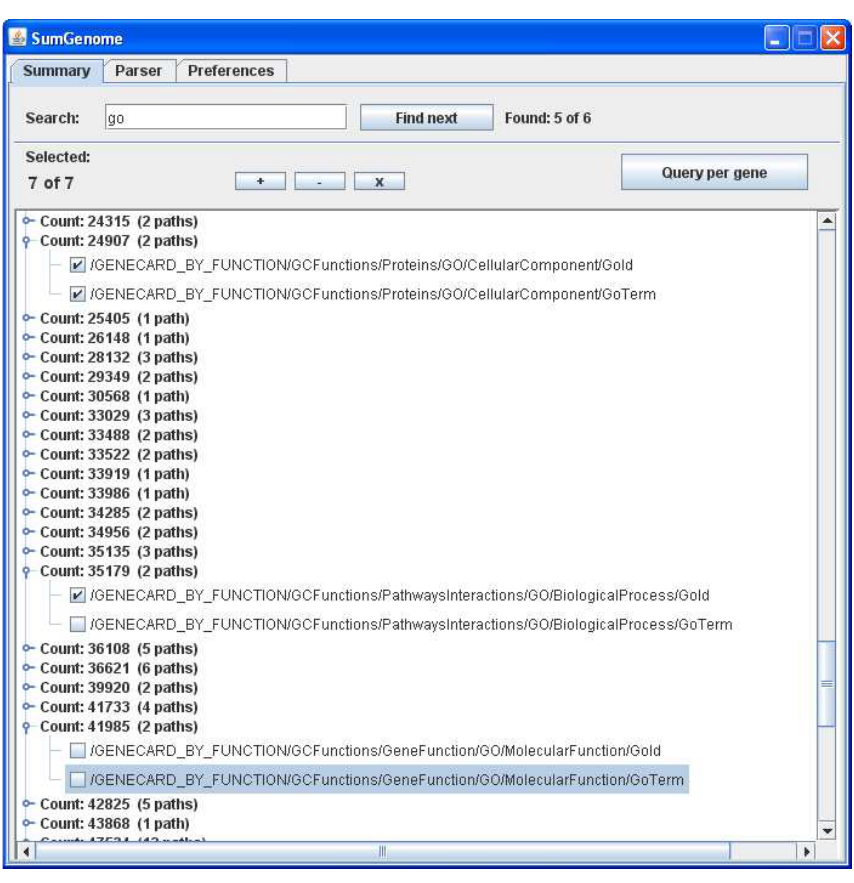
Figure 4: Paths grouped by the number of values present in data, with user searching for “go”. The user selects a path by ticking the box next to path